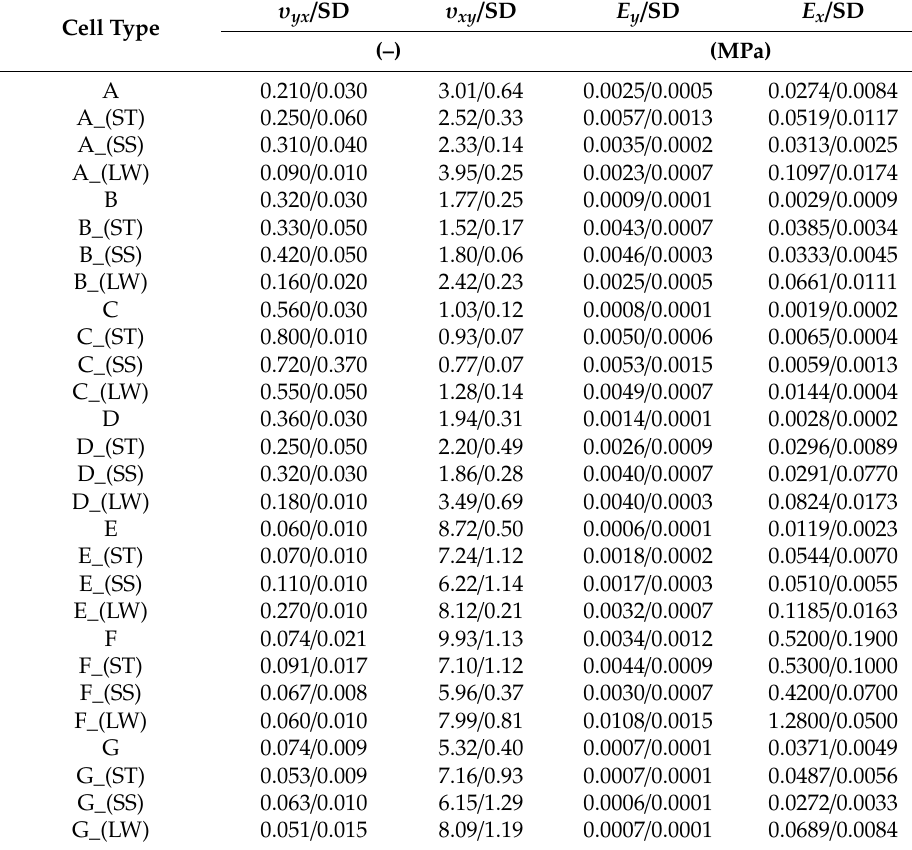
Table 3. Elastic properties of cores determined experimentally (EXP) (SD–standard